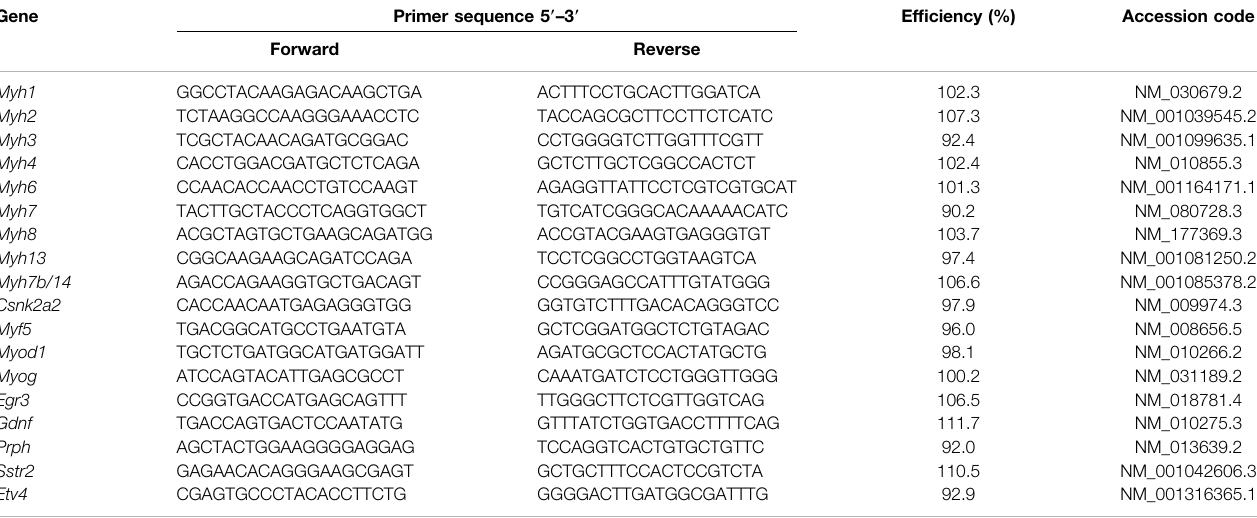
TABLE 1 | Sequence, accession code and ef fi ciency of primers used for mRNA